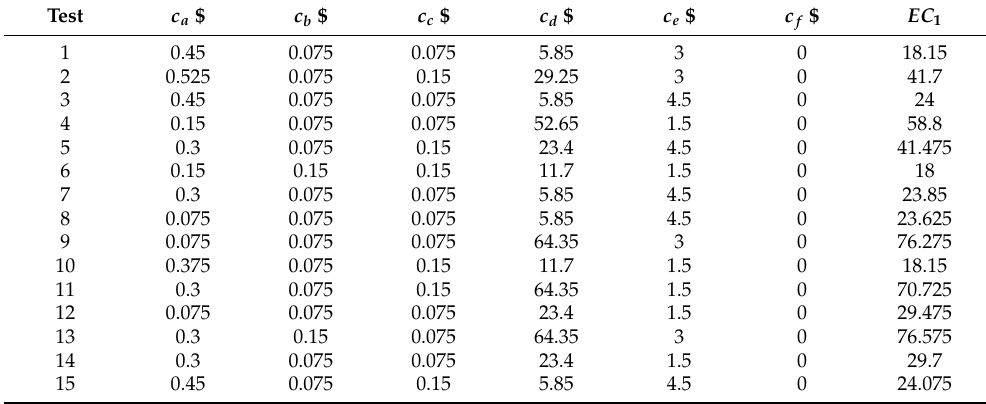
Table A5. Energy costs for standard extraction method ( i = 1).